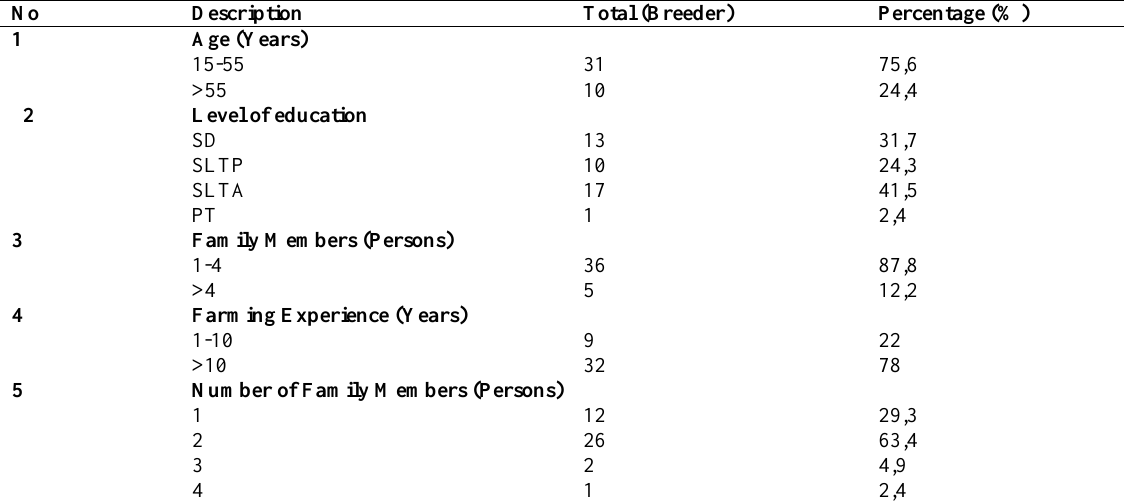
Table 1: Characteristics of Balinese Cattle Breeders in Tiworo Tengah